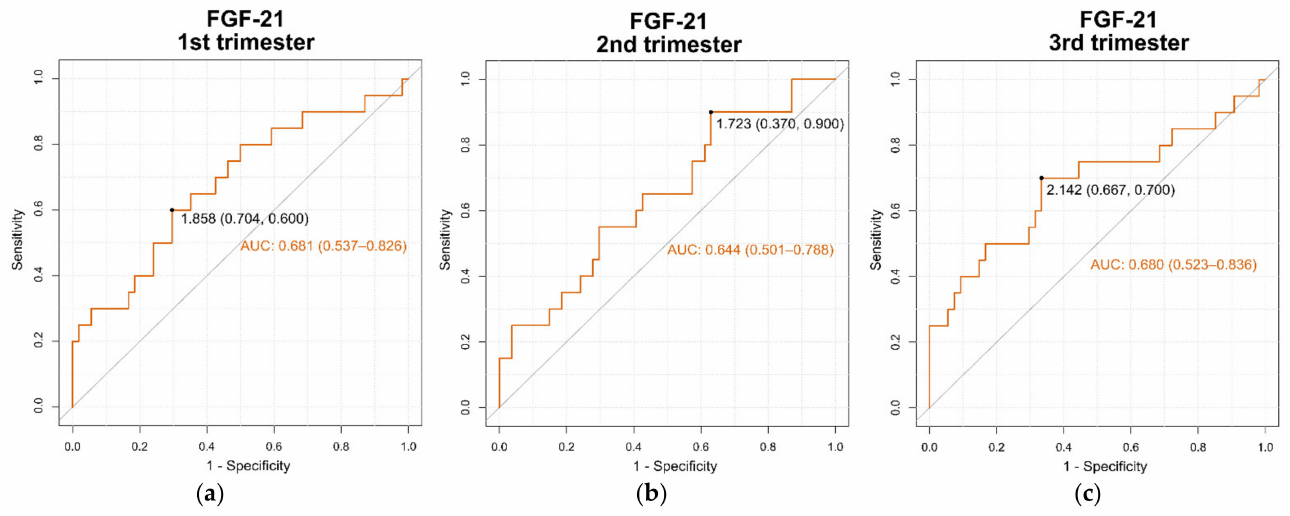
Figure 2. Receiver operating characteristic (ROC) curve of serum levels of FGF-21 (independent variable) measured in each trimester for the prediction of mild preeclampsia (dependent variable) during ( a ) 1st trimester of pregnancy; ( b ) 2nd trimester of pregnancy; ( c ) 3rd trimester of pregnancy. The optimal cut-off points (specificity, sensitivity) of serum FGF-21 levels in each trimester for predicting preeclampsia are shown. AUC: area under the curve (CI 95%).